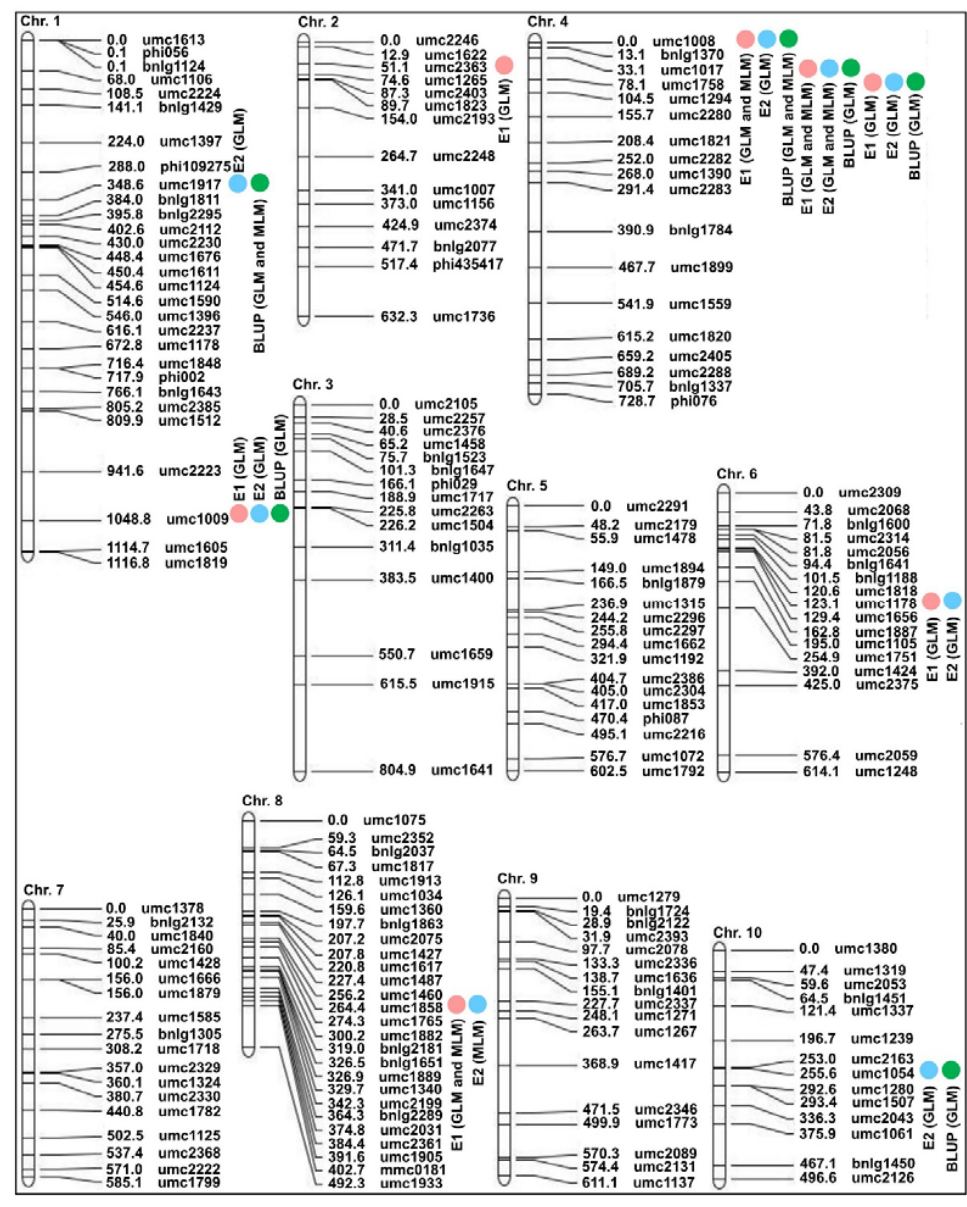
Figure 4. Genetic linkage map construction according to the genetic distance (centimorgan, cM) of 186 polymorphic SSRs on IBM2 2008 Neighbors map frame. The identified SSRs were significantly ( p < 0.01) associated with DIMBOA content in Zhangye (E1; pink circle) and Longxi (E2; blue circle) ecological environments, Gansu Province, China in 2020. The best linear unbiased prediction (BLUP; green circle) values for these SSRs were assessed using a general linear model (GLM) and mixed linear model (MLM),